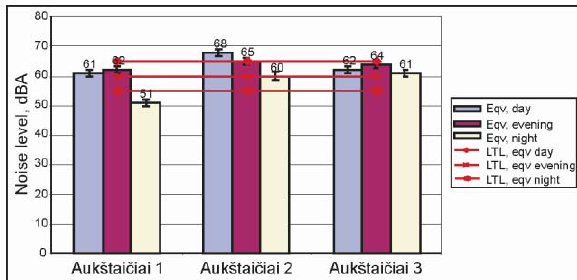
Fig. 14. Dynamics of equivalent noise levels in Aukštaičiai street within twenty four hours